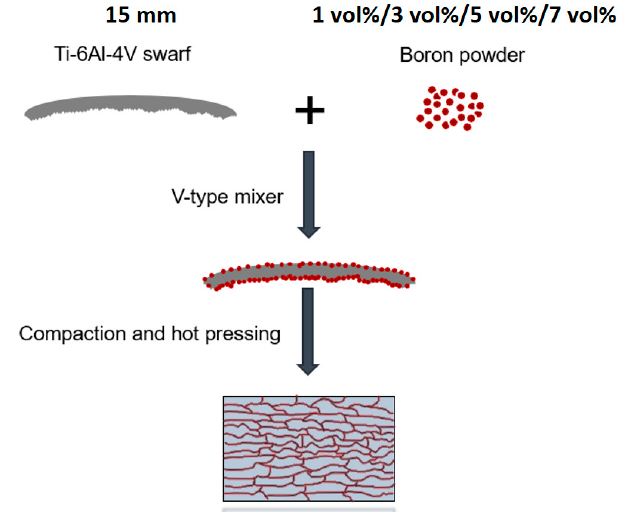
Figure 2. Schematic illustration of the powder mixing and hot-pressing process.